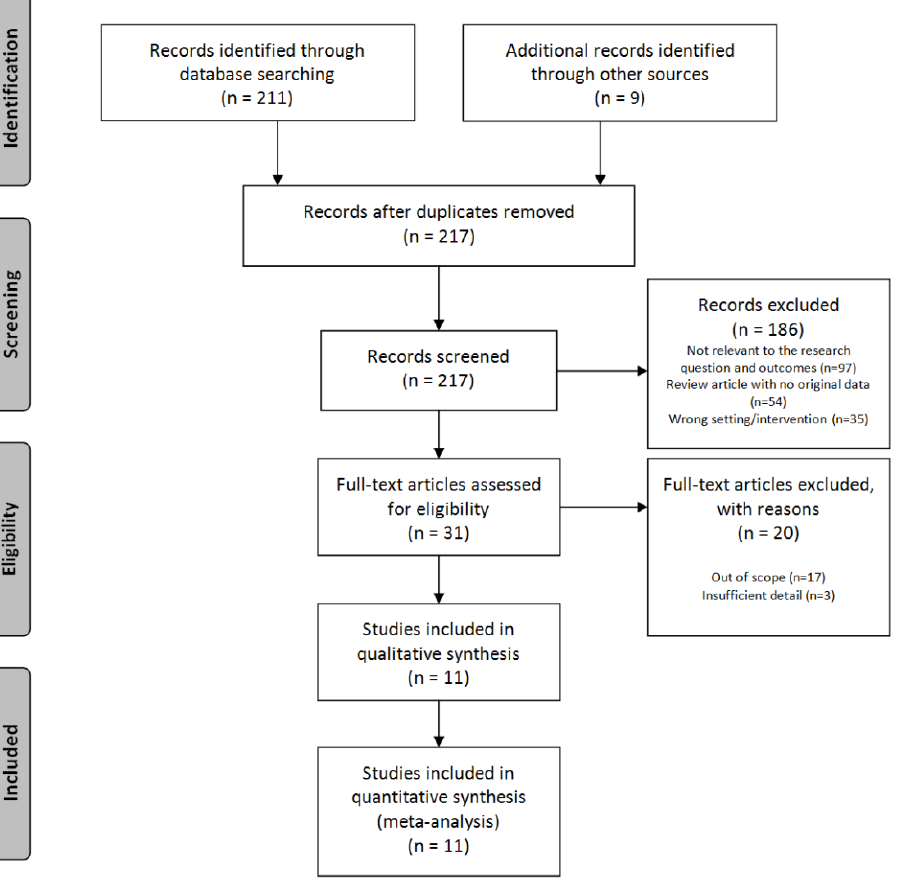
Figure 1. PRISMA flow diagram [17].